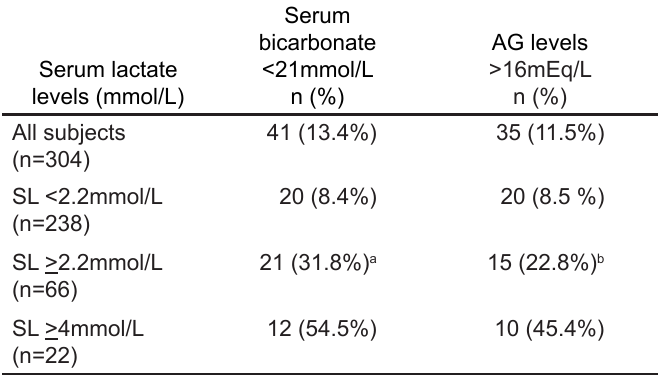
SL , serum lactate; AG , anion gap a Statistically significant differences between patients with serum lactate levels lower than 2.2 and patients with serum lactate equal or higher than 2.2mmol/L, all patients had serum bicarbonate levels lower than 21mmol/L (Chi square=24.7; p=0.00006). b Statistically significant differences between patients with serum lactate levels lower than 2.2 and patients with serum lactate equal or higher than 2.2mmol/L, all patients had AG levels greater than 16mEq/L (Chi square=14.6;